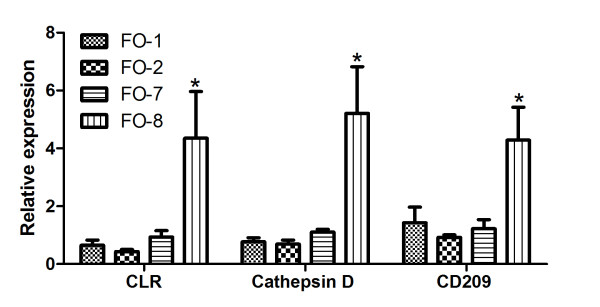
Antigen processing and presentation genes expressed in the head kidney of Atlantic salmon injected with different oil-based vaccines. qPCR expression studies of C-type lectin receptor (CLR), antigen recognition and processing by phagocytes (cathepsin D) and antigen presentation (CD209) genes identified as upregulated by microarray. FO-1 = A. salmonicida (sc); FO-2 = A. salmonicida (6 × sc); FO-7 = M. viscosa (sc); FO-8 = M. viscosa (6 × sc). Gene expression ratios normalized to EF1α. Error bars = SE, n= 7. *p < 0.05.